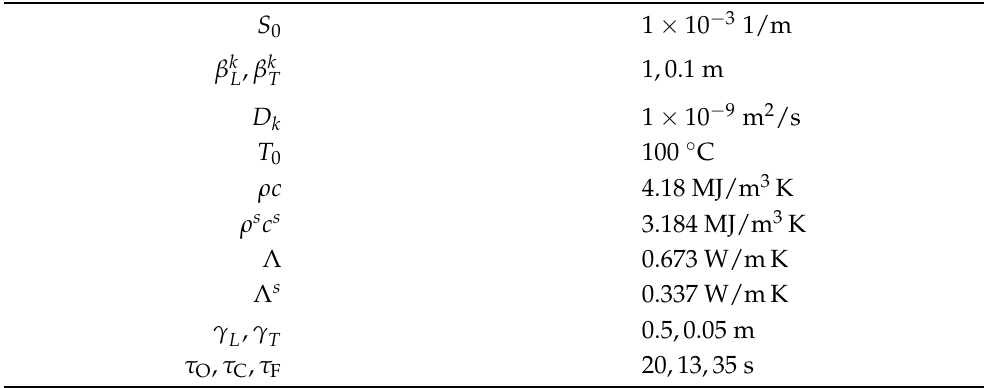
Table 8. Parameters of model (1)–(7) varying the species k , k = CF, CQA, TR, CA, AA, TA, FA, LP. These parameters are independent of granulometry, except for the extraction time τ